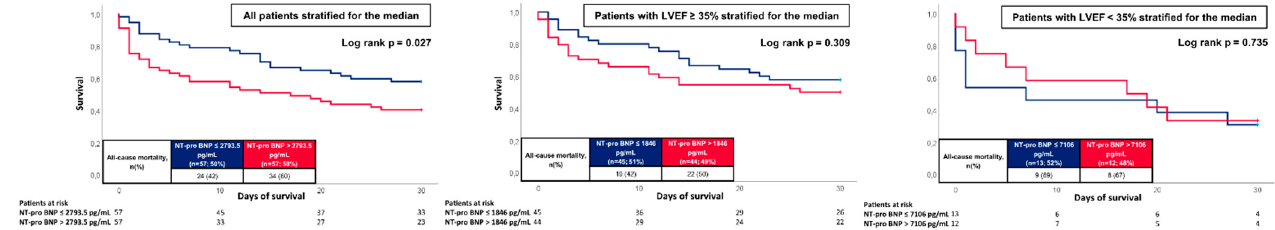
Figure 5. Kaplan–Meier curves for NT-pro BNP according to all-cause mortality at 30 days within the entire study cohort ( left ), in patients with LVEF ≥ 35% ( middle ) and in patients with LVEF < 35% ( right ).